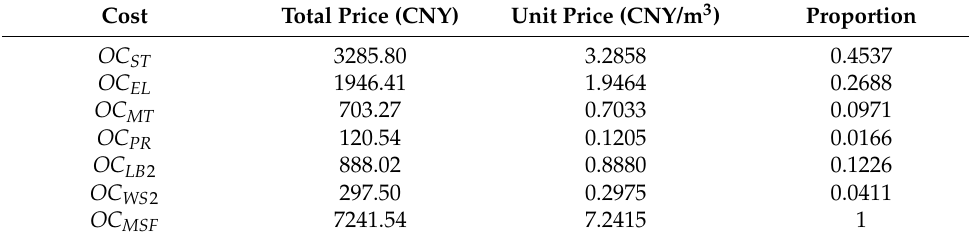
Table 23. OT-MSF system cost ratio